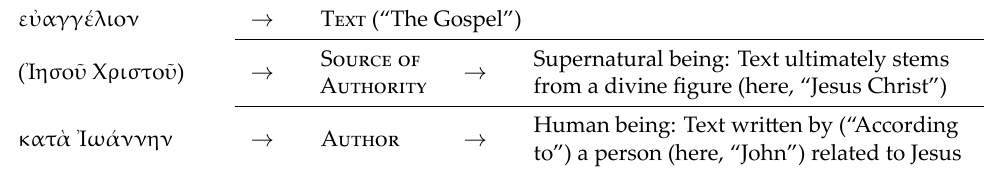
Table 1. Meaning of the Gospel TITLE: Its TEXT, SOURCE OF AUTHORITY, and AUTHOR. ε ὐ αγγ έ λι o ν → TEXT (“The Gospel”) SOURCE OF → Supernatural being: Text ultimately stems (Ἰ ησ oῦ X ριστ oῦ) → AUTHORITY from a divine figure (here, “Jesus Christ”) Human being: Text written by κατ ὰ Ἰ ω ά ννην → AUTHOR →